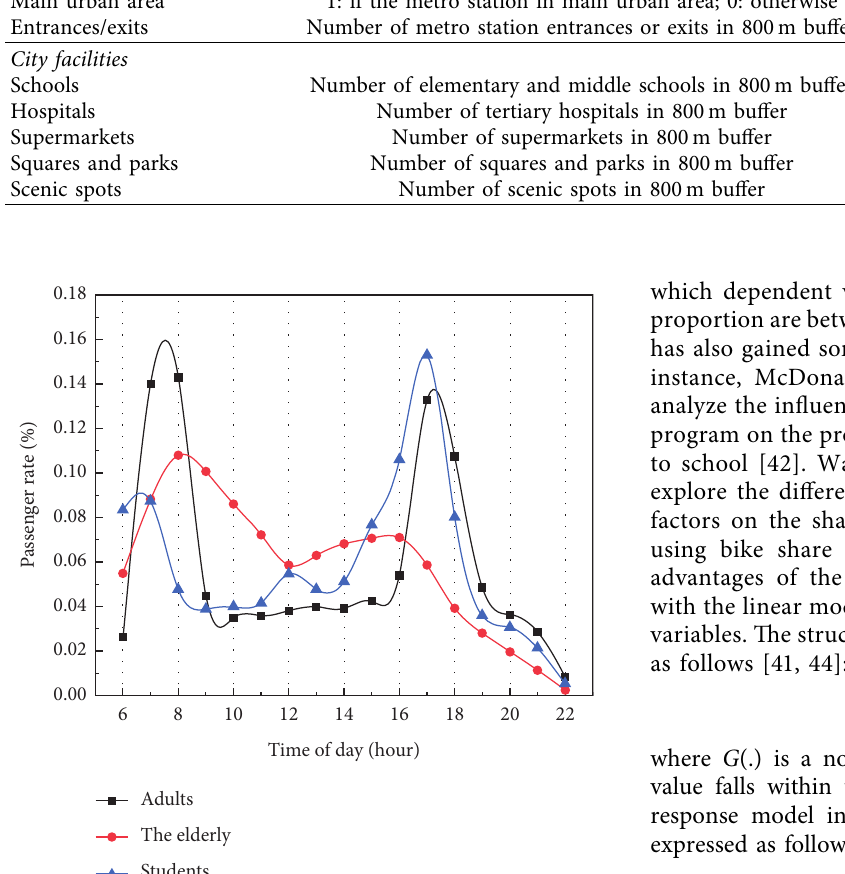
Figure 2: Proportion distribution of metro ridership among adults, the elderly, and